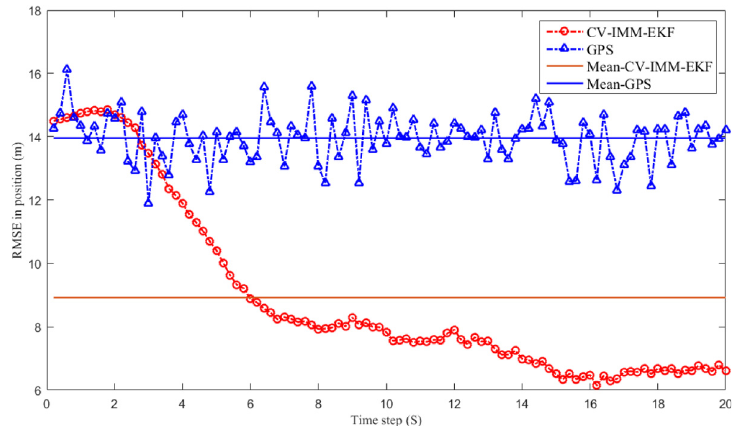
Figure 10 CV-IMM-EKF and GPS performance in positioning